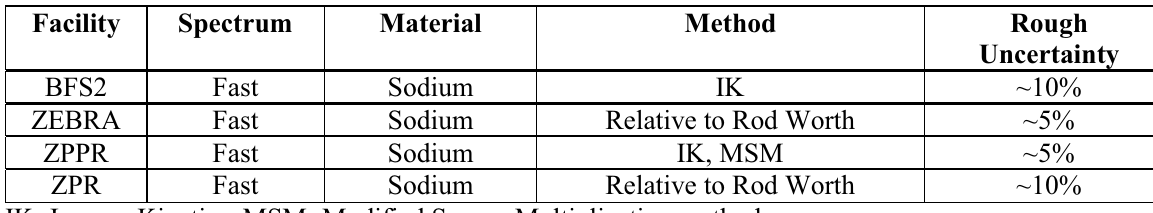
Table II.: Sodium void reactivity experimental benchmarks in the IRPhEP Handbook Facility